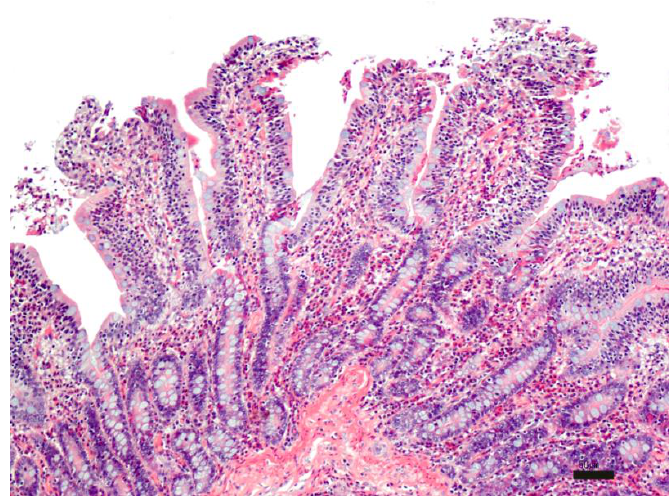
Figure 6. Histological evaluation of intestinal tissue at time zero: moderate, diffuse chronic lymphoplasmacellular and eosinophilic enteritis. HE; bar: 50 µm.